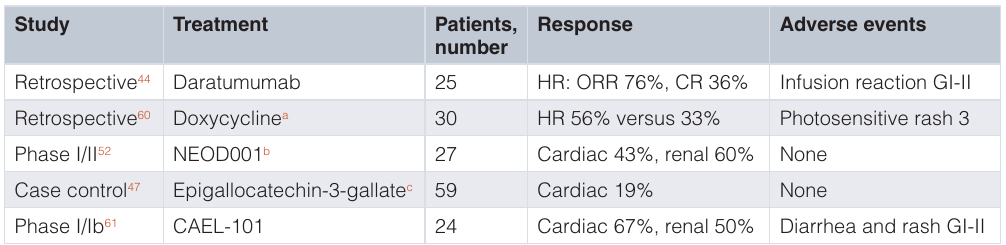
Table 3. Novel therapies for light-chain